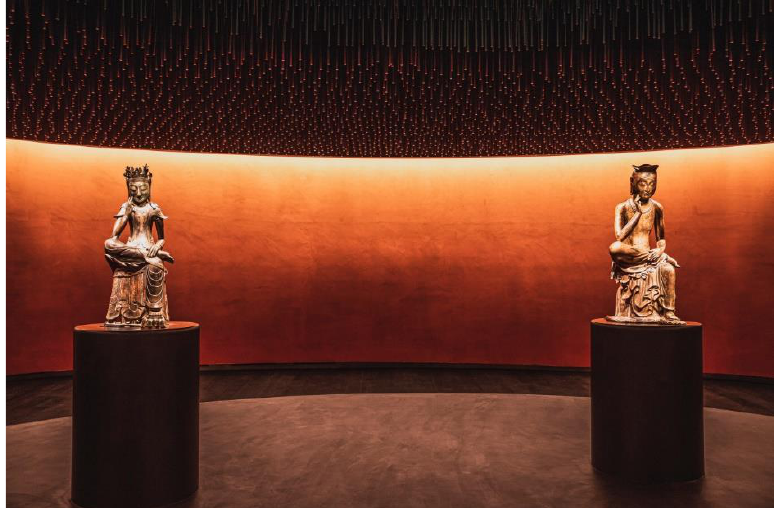
Figure 3. “A Room of Quiet Contemplation”, two Pensive Bodhisattvas, Three Kingdoms period (57 BCE-668 CE). National Museum of Korea, Seoul. Photo from The Korean JoongAng Daily, 1 February 2022. Photo in public domain.